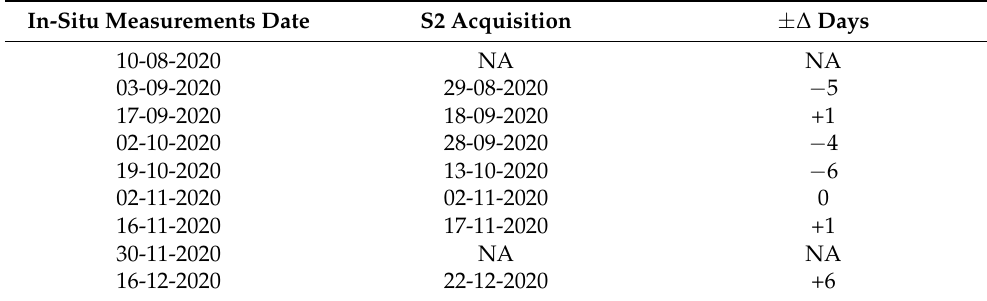
Table 5. Field campaign and Sentinel-2 acquisition dates.